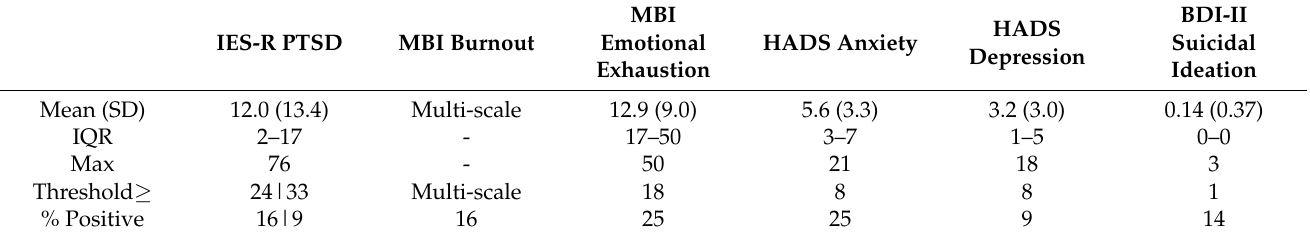
Table 1. Descriptive Statistics, Positivity Thresholds and Counts for IES-R PTSD, MBI Burnout, MBI Emotional Exhaustion, HADS Anxiety, HADS Depression Scales and Suicidal